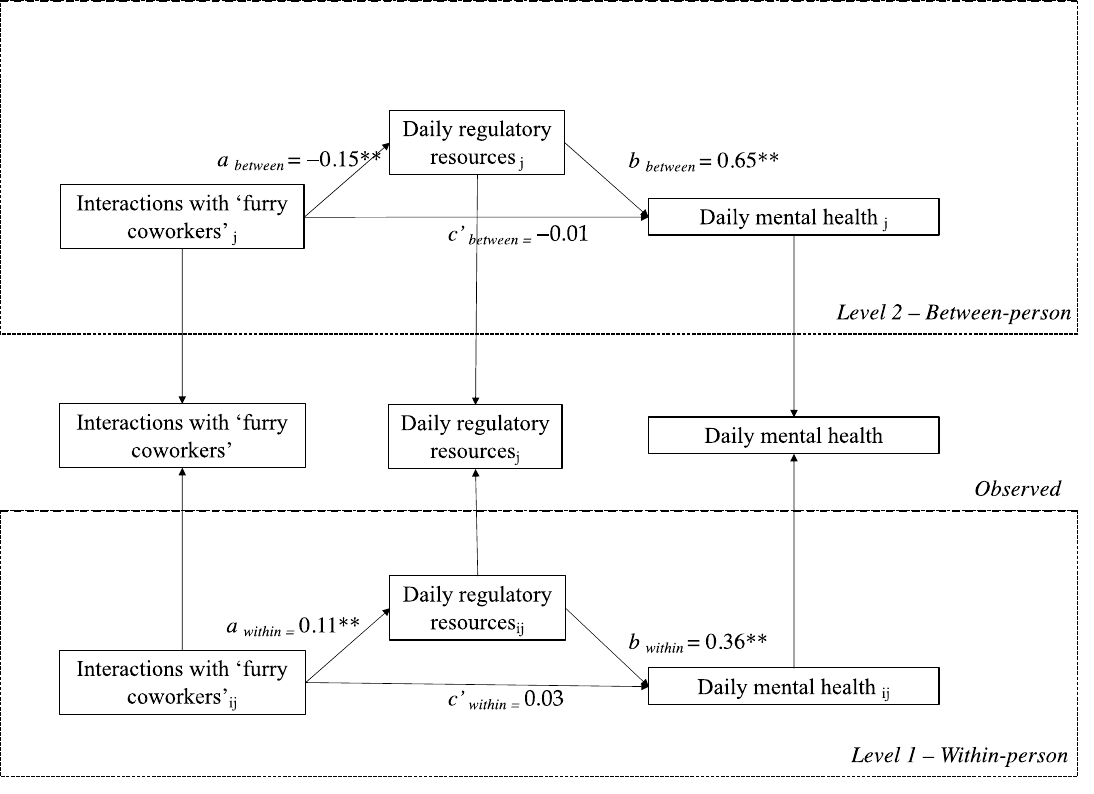
Figure 2. The multilevel mediating model. Maximum-likelihood estimation with robust standard errors (MLR) was used in the estimation. L 1 = level 1 (1055), L 2 = level 2 analysis (211). ** p < 0.01. R 2 = 25.7. AIC = 4705.11; BIC = 4735.47; − 2LL = 4705.11.